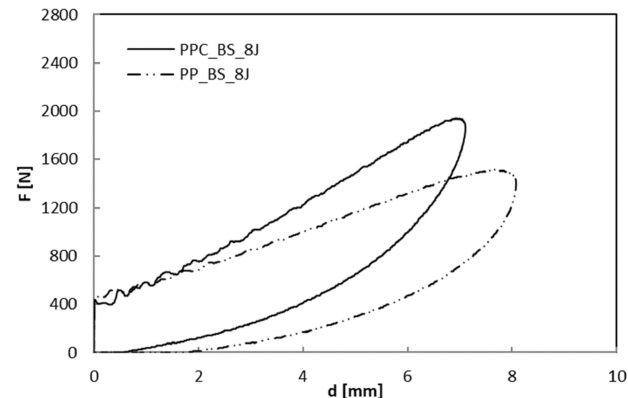
Figure 8. Load–displacement curves at indentation: comparison between BS_PP and BS_PPC; U = 8 J.